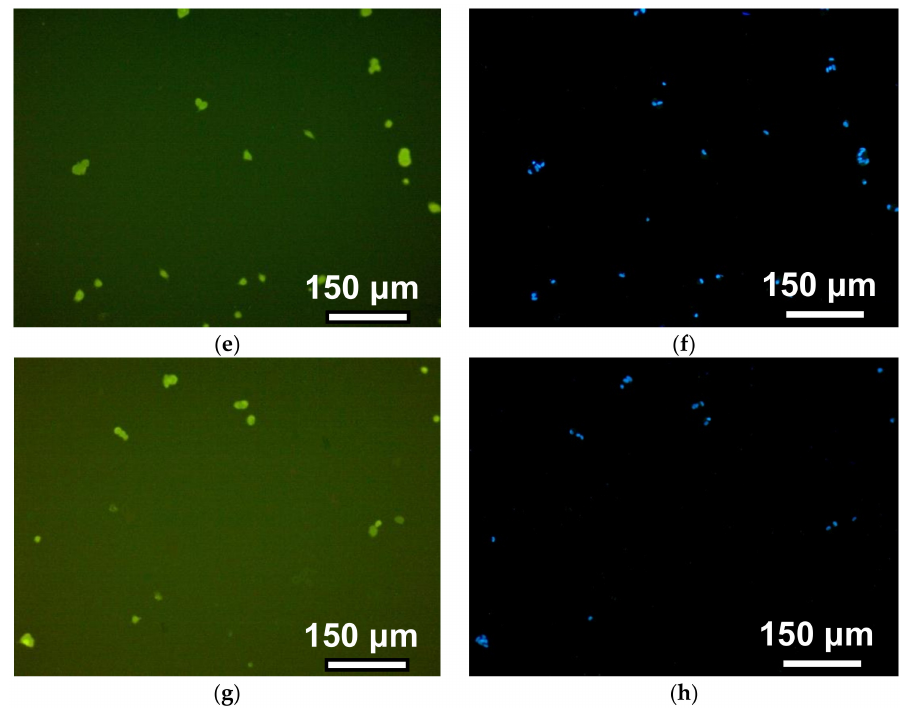
Figure 6. Adhesion of human dermal fibroblasts on PAAm gels with different crosslinking densities. Images were taken 12 h after seeding, staining of the cytoplasm of cells with pyrazolone yellow ( a , c , e , g ), and staining of nuclei with a solution of DAPI ( b , d , f , h ). Photos from top to bottom correspond to gels with a crosslinking density of 1:50 ( a , b ), 1:100 ( c , d ), 1:200 ( e,f ), and 1:300 ( g , h ).